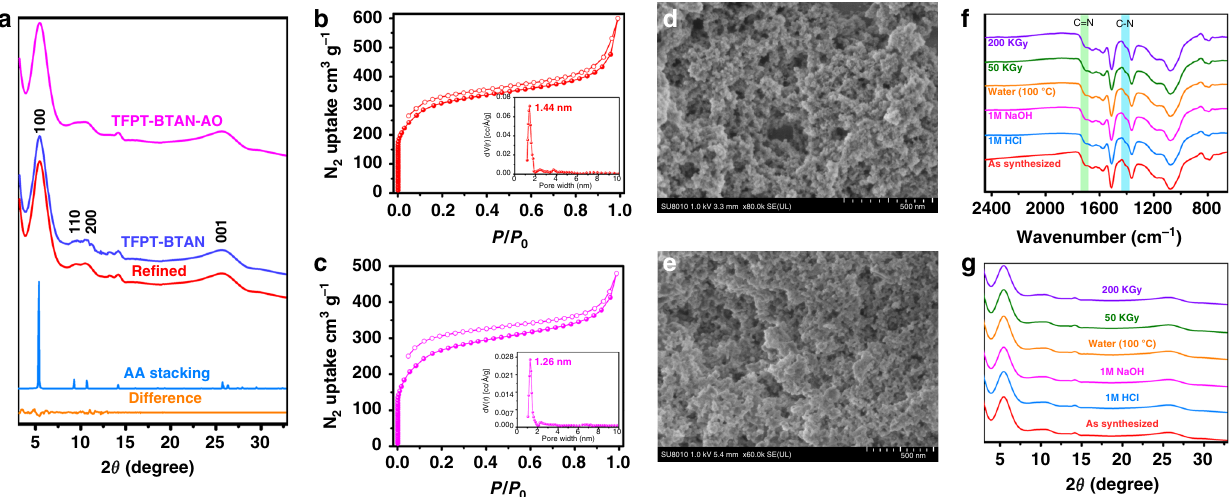
Fig. 2 Characterization of TFPT-BTAN and TFPT-BTAN-AO. a PXRD pro fi les. Nitrogen adsorption – desorption isotherms of b TFPT-BTAN and c TFPT- BTAN-AO. Insets: the pore-size distributions calculated from non-local density functional theory. SEM images of d TFPT-BTAN and e TFPT-BTAN-AO. f FT-IR spectra and g PXRD pro fi les of TFPT-BTAN-AO before and after treatment with water (100 °C), HCl (1 M), NaOH (1 M), and γ -ray irradiation (50 kGy, 200